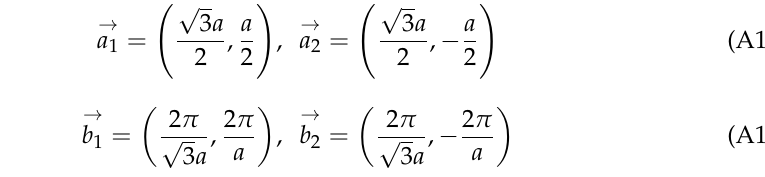
Figure A1. Single-layer graphene. ( a ) Real space and 𝑎 1 ⃗⃗⃗⃗ , 𝑎 2 ⃗⃗⃗⃗ basis vectors; ( b ) reciprocal space and 𝑏 1 ⃗⃗⃗ , 𝑏 2 ⃗⃗⃗⃗ basis vectors; ( c ) Brillouin zone.